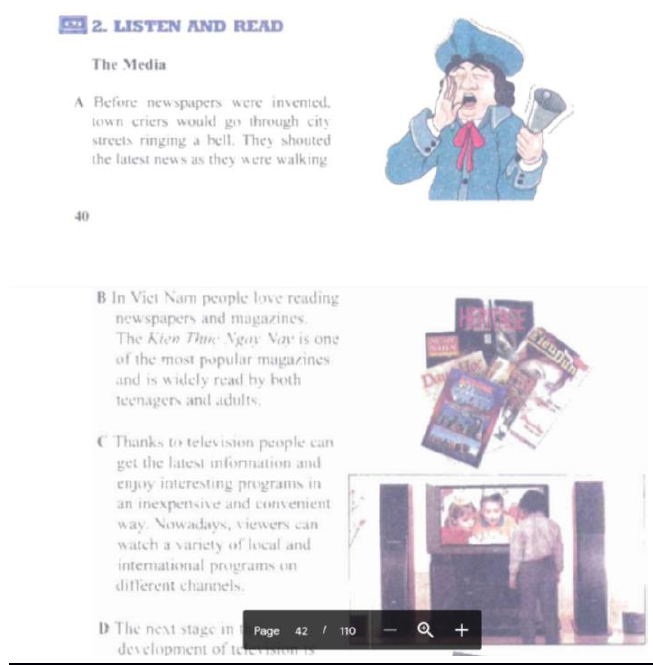
Figure 2. Screenshots from the English